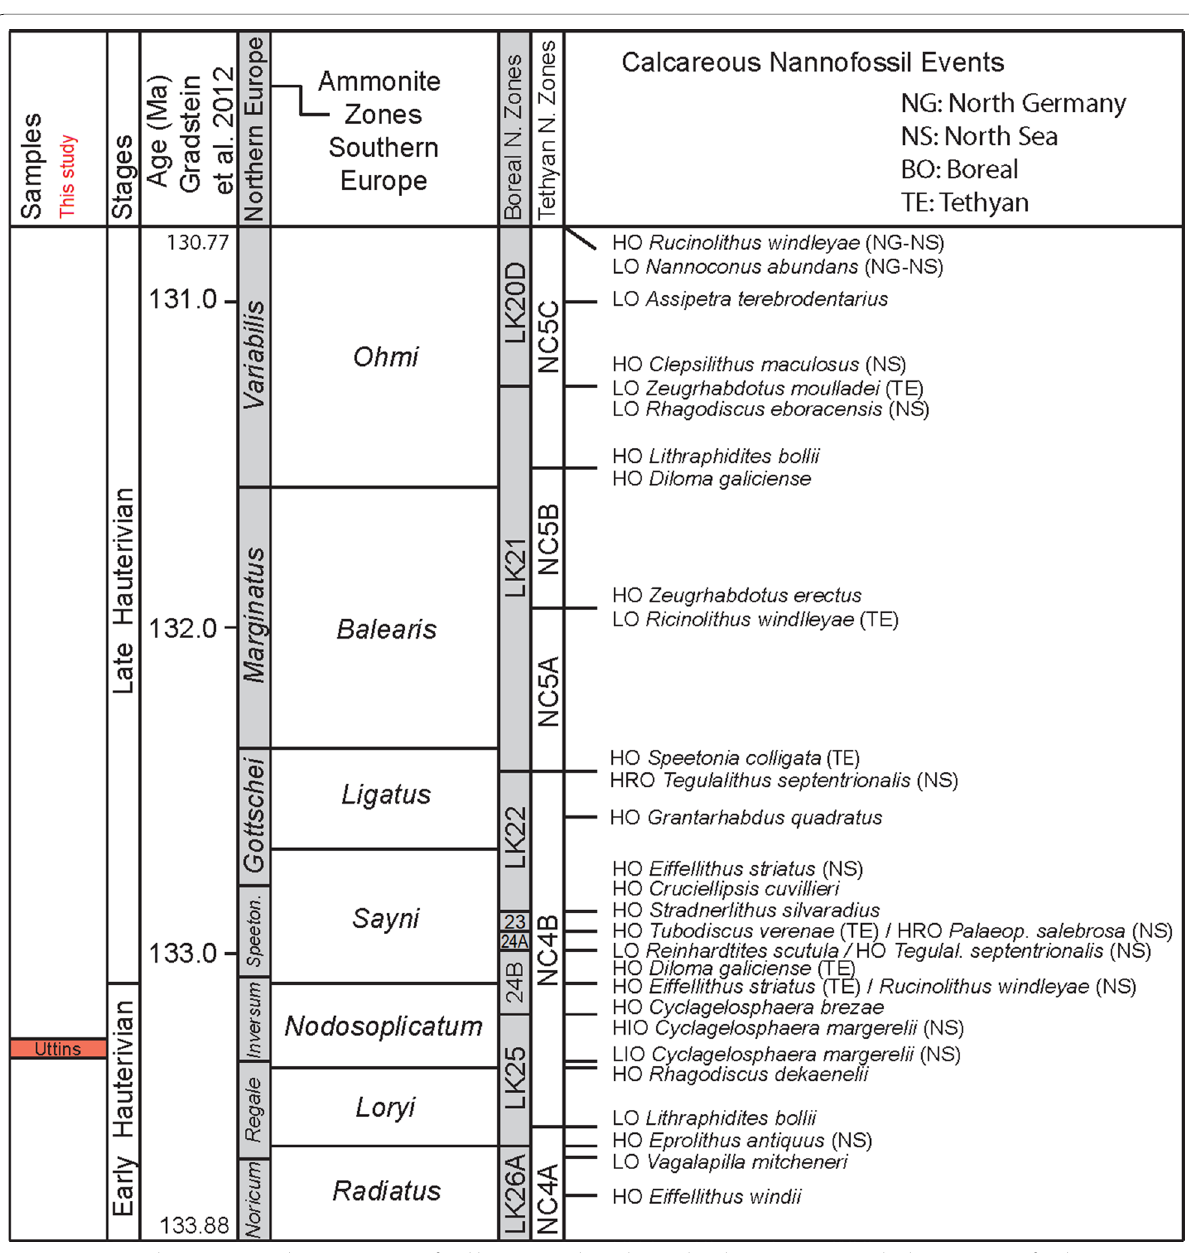
Fig. 14 Integrated Hauterivian and Barremian nannofossil biostratigraphy with Boreal–Tethyan ammonite and calcareous nannofossil zones calibrated to ages from Gradstein et al. (2012). Boreal LK Zones by Jeremiah (2001) and Tethyan NC Zones by Roth (1978, 1983) with subdivisions of Bralower (1987), modified by Applegate and Bergen (1988) for the Hauterivian. In the left column, the stratigraphic position is indicated within red frameworks for the samples from the Uttins Marls (Uttins/Mont de Chamblon section, VD) and Corcelles Marls (C‑2/Corcelles‑2 section, NE), and in blue frameworks for the samples from Eclépens (EC) and La Sarraz–Les Buis (LSBM) previously studied by De Kaenel et al. (2020). The following terms are used to indicate the individual species abundance: HO highest occurrence, HRO highest regular occurrence, HFO highest few occurrence, = = = HIO highest increase occurrence, LIO lowest increase occurrence, LFO lowest few occurrence, LRO lowest regular occurrence, LO lowest = = = = =